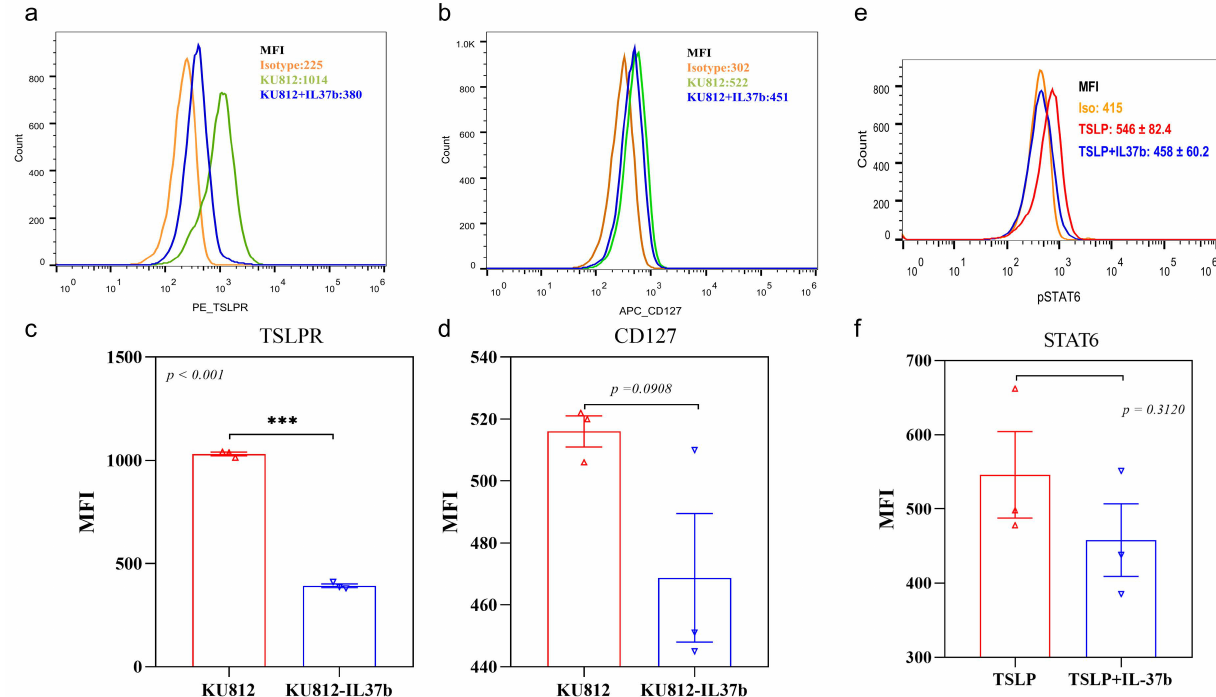
Figure 1. Effects of IL-37b on the expression of TSLP receptor of KU812 cells analyzed by flow cytometry. ( a ) TSLPR and ( b ) CD127; ( c , d ) quantitative flow cytometry analysis of TSLPR and CD127; ( e ) pSTAT6 and ( f ) quantitative analysis of pSTAT6. Bar charts are shown as mean ± SEM of triplicate independent experiments. *** p < 0.001 when compared between the